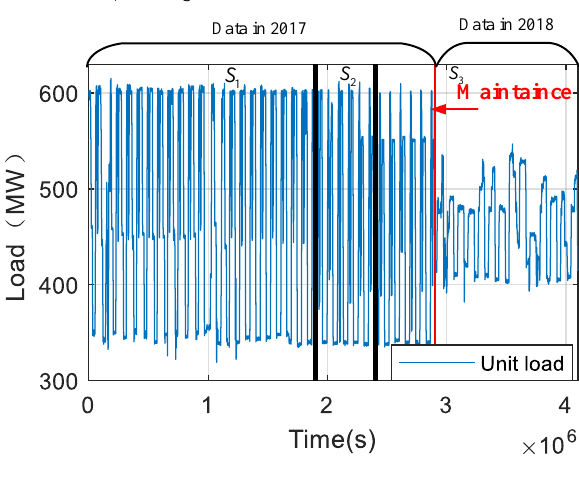
Figure 14. Data Figure 14. Data partition.